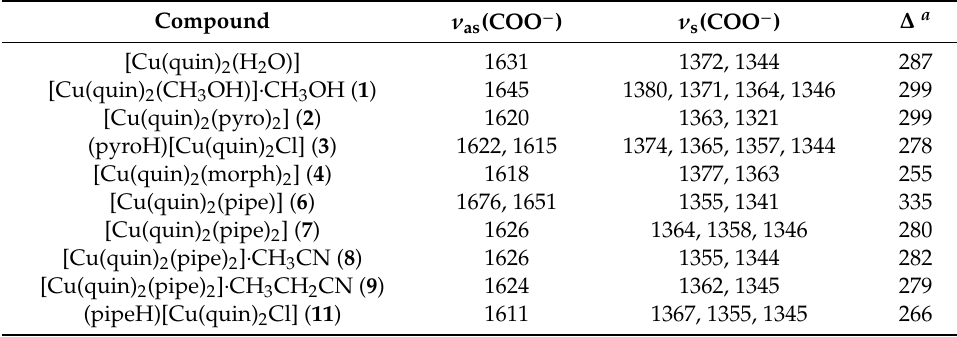
Table 2. Carboxylate bands [cm − 1 ] in the IR spectra of 1 – 11